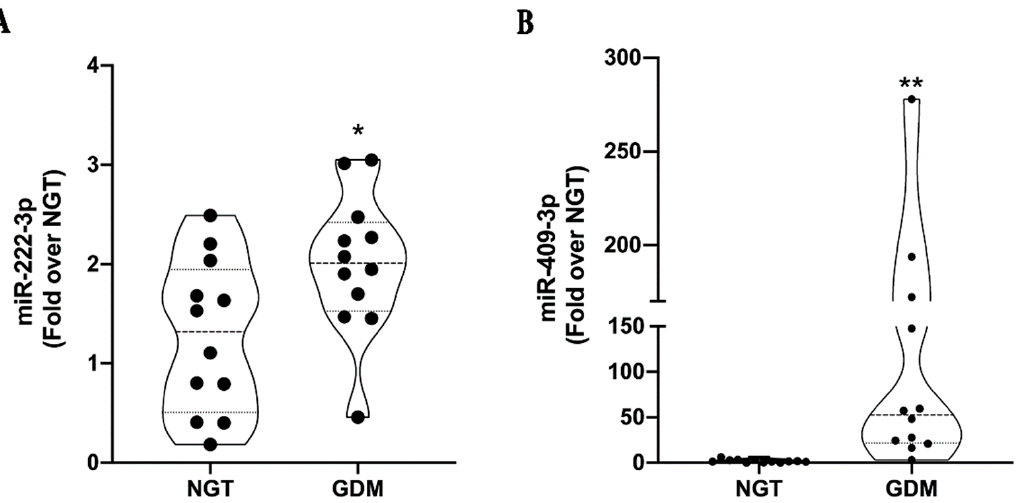
Figure 3. RT-qPCR analysis of miR-222-3p and miR-409 in the validation cohort. RT-qPCR was used to analyze miR-222-3p ( A ) and miR-409-3p ( B ) in the total plasma compartment of the GDM ( n = 12) and NGT ( n = 12) validation cohort. The analysis confirmed the upregulation of these two miRNAs in GDM patients vs. NGT subjects. Significance was calculated with GraphPad Prism software by using the two-tailed t-test and calculating the difference between the mean of GDM vs. NGT ± stand- ard error of the mean (SEM). * p < 0.05, ** p < 0.01.